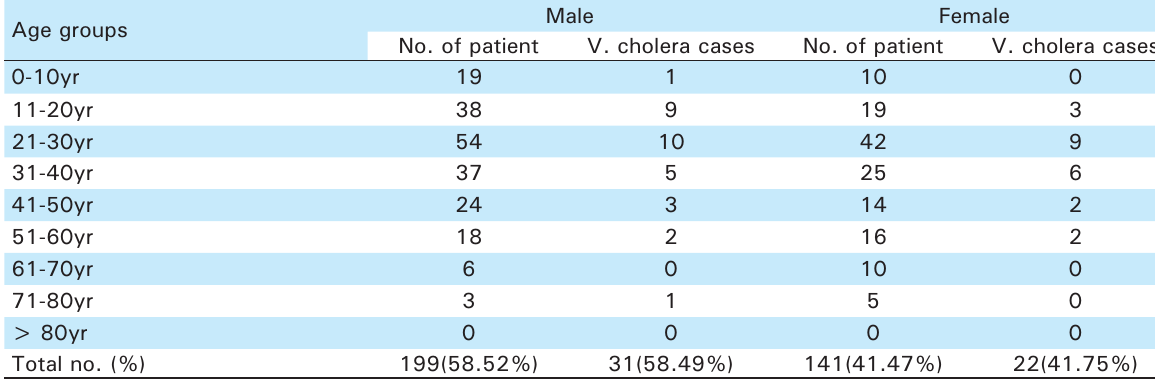
Table 1. Age and gender wise distribution of samples and V. cholera cases Age